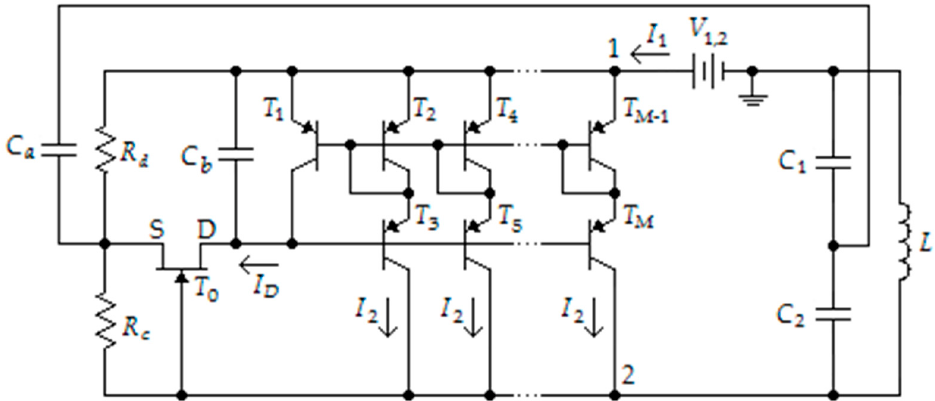
Figure 7. NDR oscillator with multiple-output Wilson current mirror.